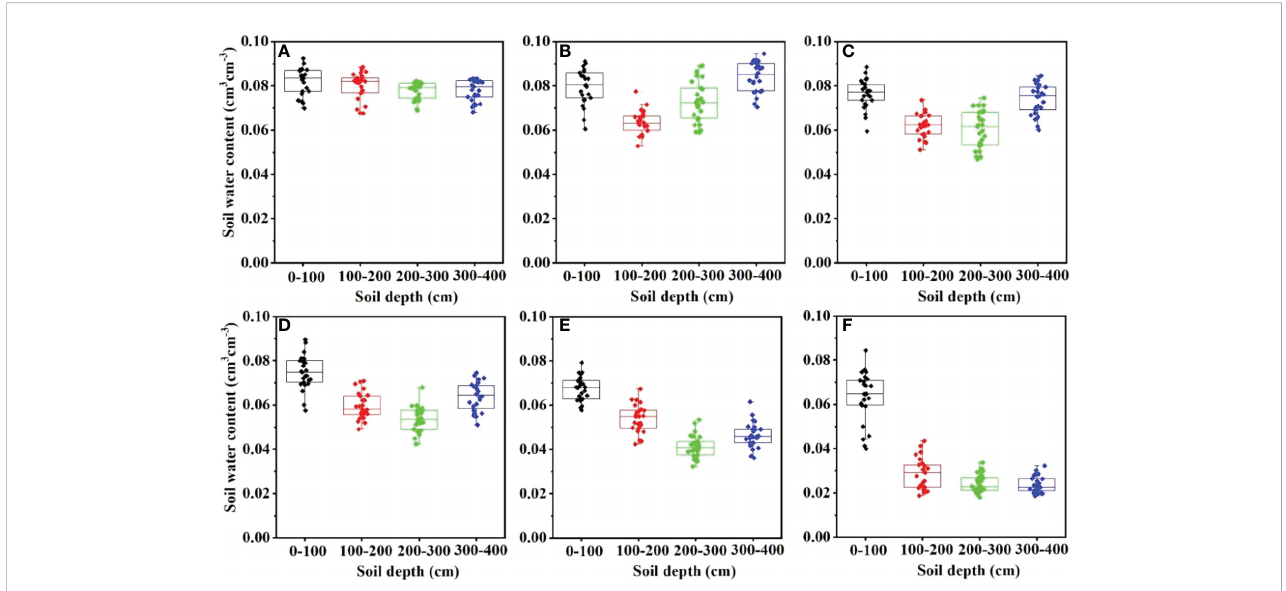
FIGURE 3 A boxplot of the vertical distribution of soil water content (SWC) in HA plantations: (A) wasteland, (B) 5-year-old, (C) 11-year-old, (D) 22-year-old, (E) 34-year-old and (F)